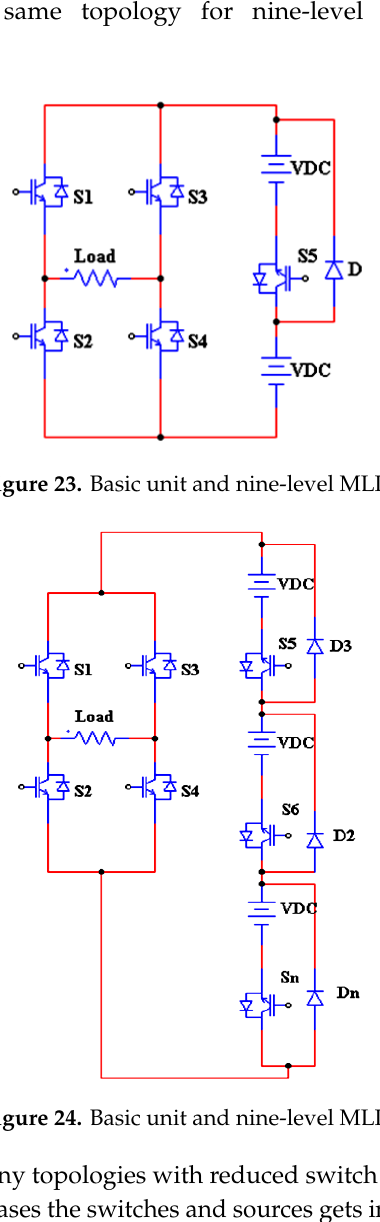
Figure 24. Basic unit and nine-level MLI.